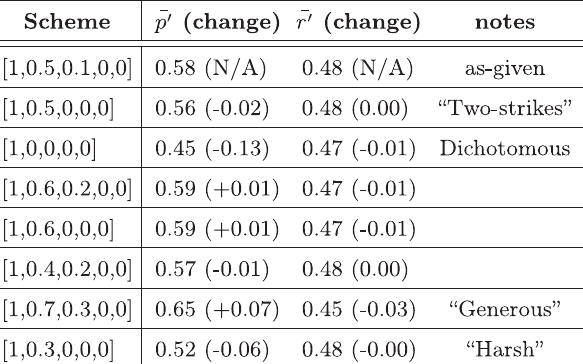
TABLE III. Analysis of partial credit granted within ITs. TABLE IV. Effects on the average testlet score and discrimi- nation of various hypothetical MC item scoring schemes. All six testlets used on the red and blue final exams are considered. “ (change) ” denotes deviation from that obtained using the actual, as given, scoring